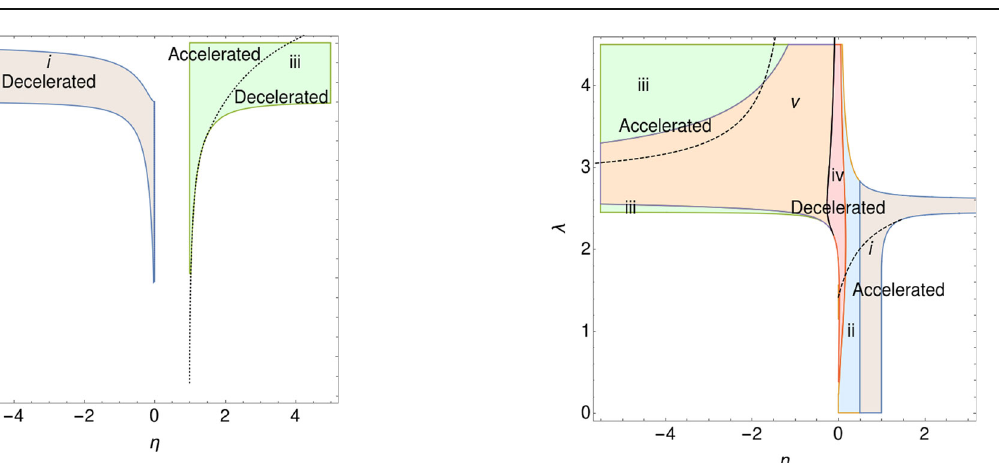
Fig. 8 Part of the region of existence of solution for the critical point K − when α = − β ≡ η .Theregionlabeledbyicontainssaddlepoints,ii stable points, iii unstable points, iv spiral stable points, v spiral unstable points and center points on black line. The black dotted curves divide the accelerated and decelerated universe